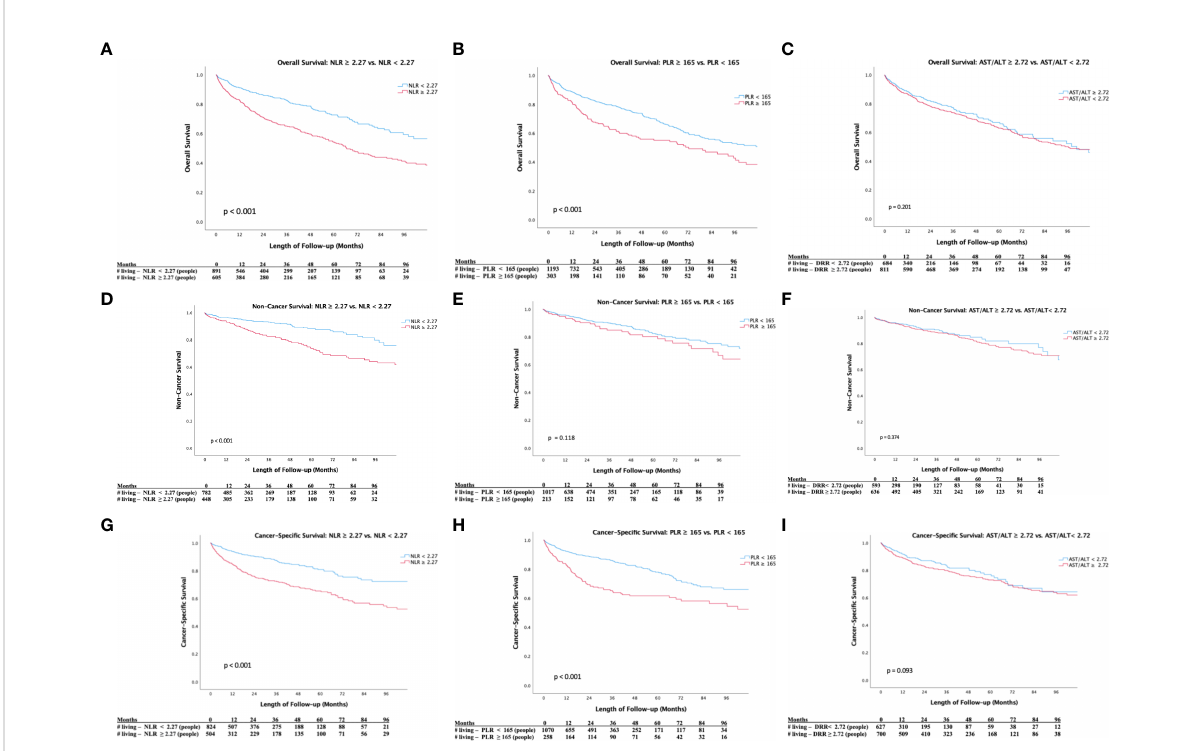
FIGURE 1 (A) Kaplan-Meier Survival Analysis of Overall Survival (NLR ≥ 2.27 vs. NLR <2.27). (B) Kaplan-Meier Survival Analysis of Overall Survival (PLR ≥ 165 vs. PLR< 165). (C) Kaplan-Meier Survival Analysis of Overal Survival (De Ritis Ratio ≥ 2.72 vs. De Ritis Ratio < 2.72). (D) Kaplan-Meier Survival Analysis of Non-Cancer Survival (NLR ≥ 2.27 vs. NLR <2.27). (E) Kaplan-Meier Survival Analysis of Non-Cancer Survival (PLR ≥ 165 vs. PLR< 165). (F) Kaplan-Meier Survival Analysis of Non-Cancer Survival (De Ritis Ratio ≥ 2.72 vs. De Ritis Ratio < 2.72). (G) Kaplan-Meier Survival Analysis of Cancer-Speci fi c Survival (NLR ≥ 2.27 vs. NLR <2.27). (H) Kaplan-Meier Survival Analysis of Cancer-Speci fi c Survival (PLR ≥ 165 vs. PLR< 165). (I) Kaplan-Meier Survival Analysis of Cancer-Speci fi c Survival (De Ritis Ratio ≥ 2.72 vs. De Ritis Ratio <